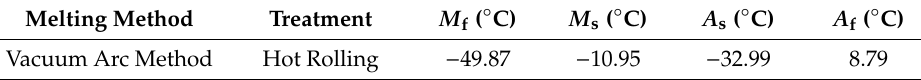
Figure 1. Stress–strain curve of NiTi SMA. Table 3. Phase transformation temperatures of the NiTi SMA.